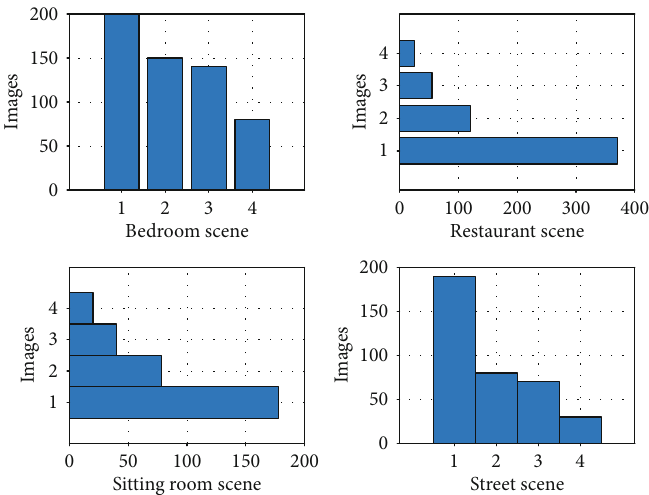
Figure 7: Statistical results of Object Bank features in four di ff erent